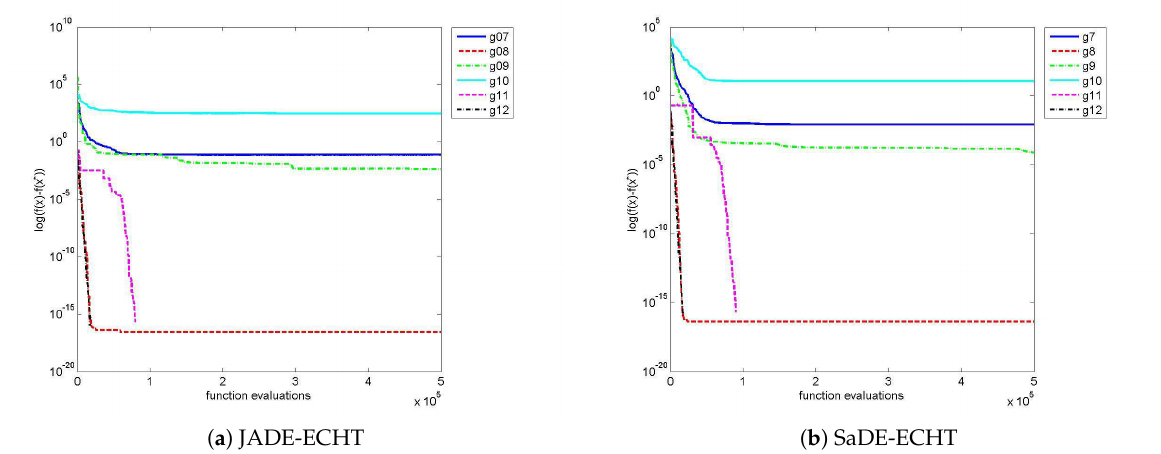
Figure 5. Convergence comparison of JADE-ECHT and SaDE-ECHT for